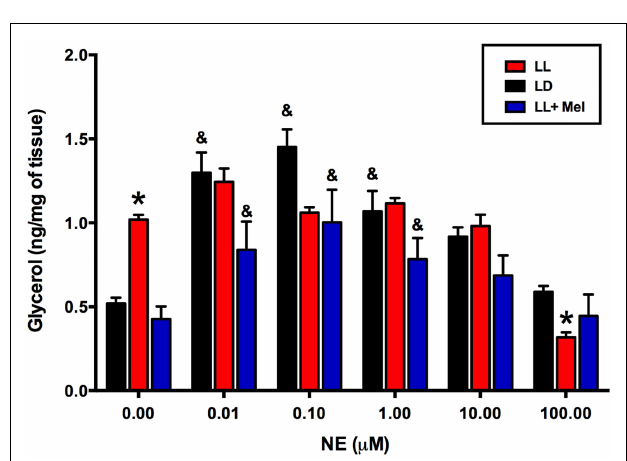
FIGURE 7 | Glycerol response to increasing doses of NE of perirenal adipose tissue explants from 5days old lambs . Data are means ± SEM. LD, newborns gestated in ewes exposed to photoperiod 12:12; LL, newborns gestated in ewes kept in continuous light from 60% gestation to term and LL + Mel, newborns gestated in ewes kept in continuous light but receiving an oral dose of 12mg melatonin at 1700h. N = 6 per group. * P < 0.05 vs. LD; & P < 0.05 vs. 0 NE. ANOVA andTukey’s